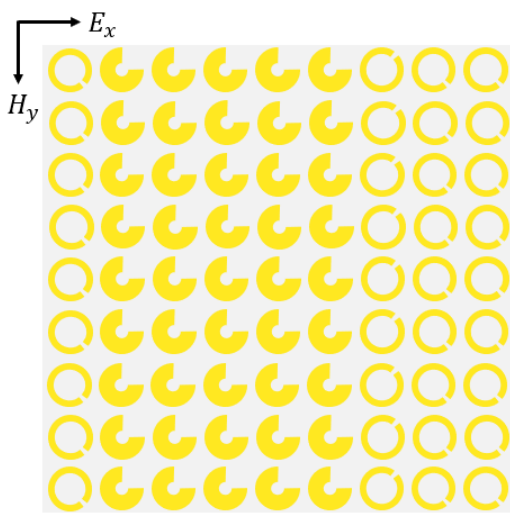
Figure 2. Schematic diagram of the part single-layer metal meta-lens in the x–y plane. The phase distribution corresponding to different positions along the x direction of